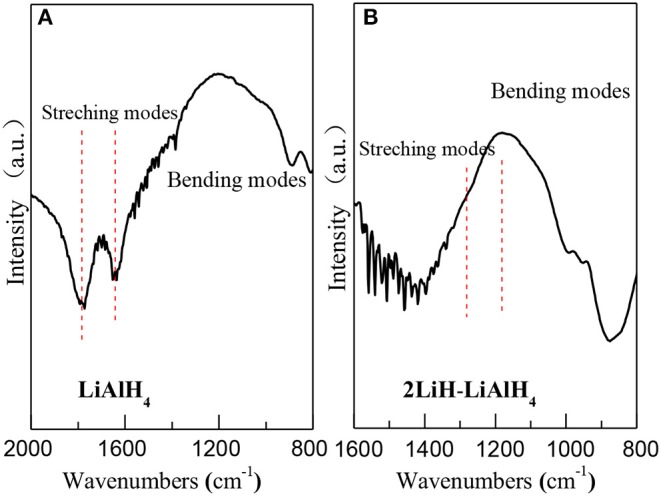
FT-IR spectrums of (A) pure LiAlH4 and (B) 2LiH-LiAlH4 mixed powder after 50-h ball milling.